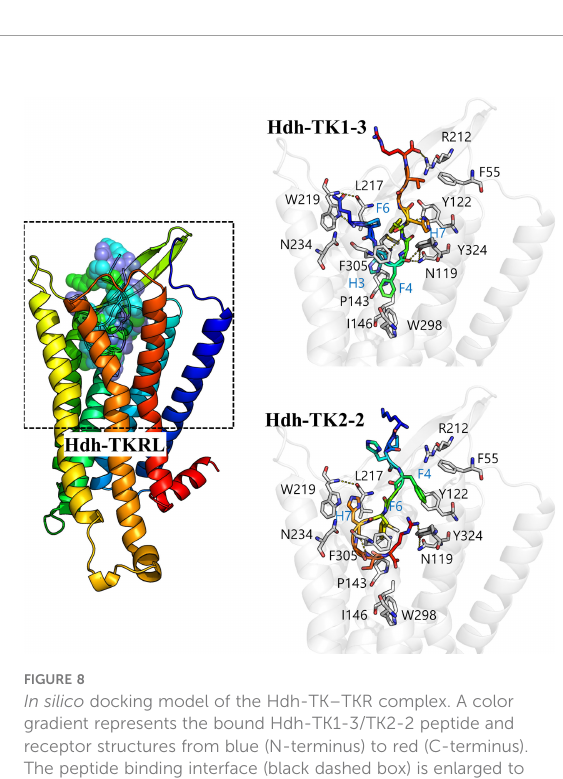
fi rst and subsequent duplication of TKR. Two abalone